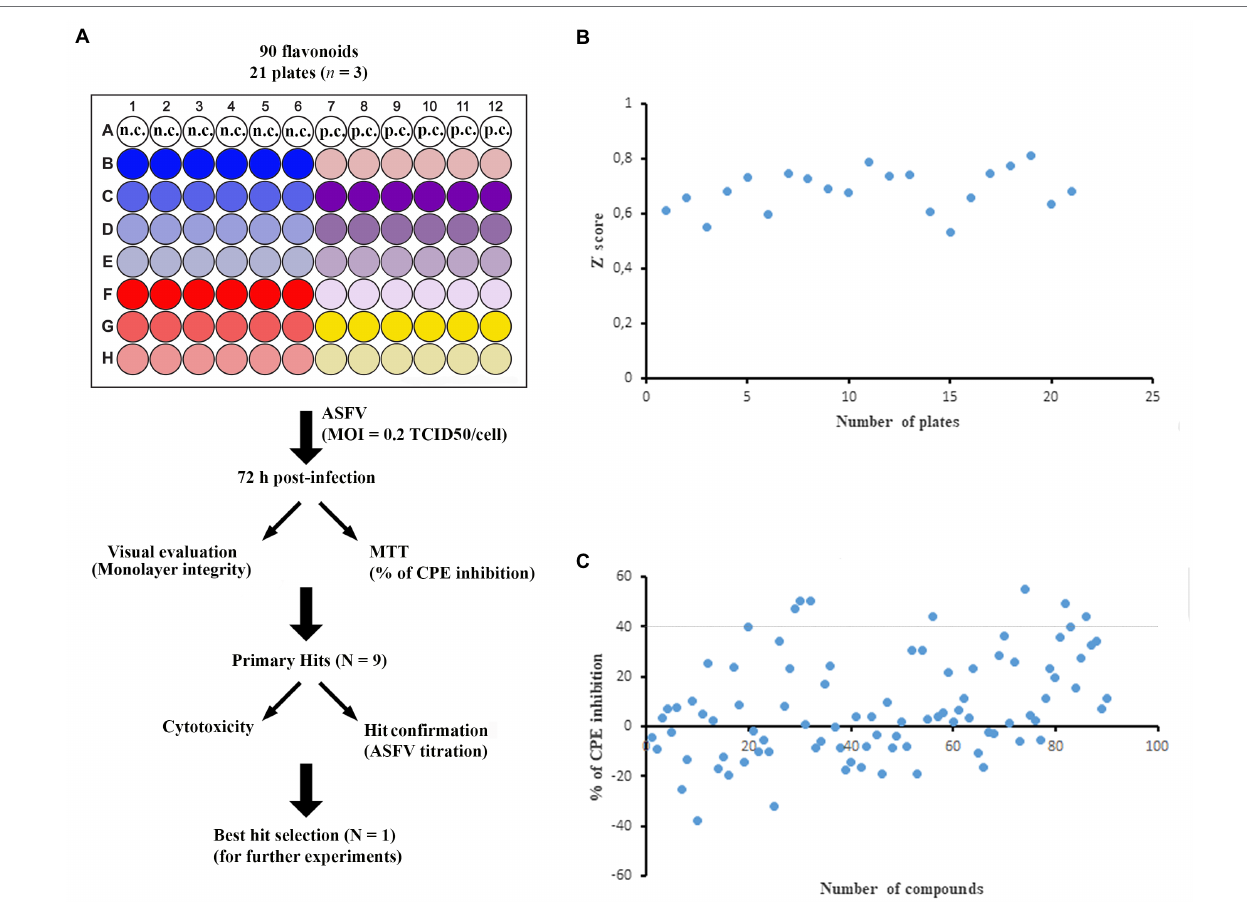
FIGURE 1 | Cell-based library screening. (A) Schematic representation of screening outline. ASFV-infected Vero cells were treated with each compound at indicated concentration (6 wells per compound). DMSO was dispensed into wells as a negative control, whereas apigenin was used as a positive control. After 72 h post-infection, all wells were visually monitored and stained with MTT. n.c. and p.c. stand for negative control and positive control, respectively. (B) Plot of the Z ' score of each plate. The Z ' score was calculated by using maximum (DMSO; negative control) and minimum (apigenin; positive control) MTT values. (C) Inhibition of viral CPE by tested compounds. Compounds that inhibited ASFV-induced CPE by ≥ 40% were selected for further validation. All experiments were conducted in triplicate. The standard deviation of each compound was not included in the figure for presentation